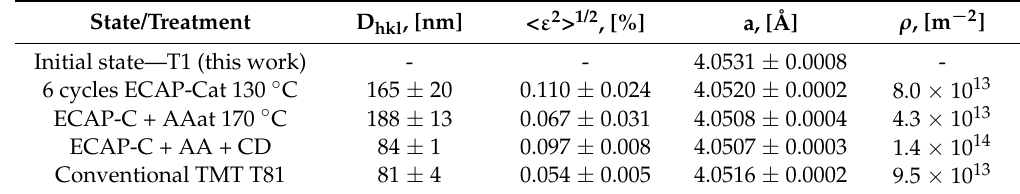
Table 1. Results of the X-ray diffraction analysis of the Al 6101 alloy.